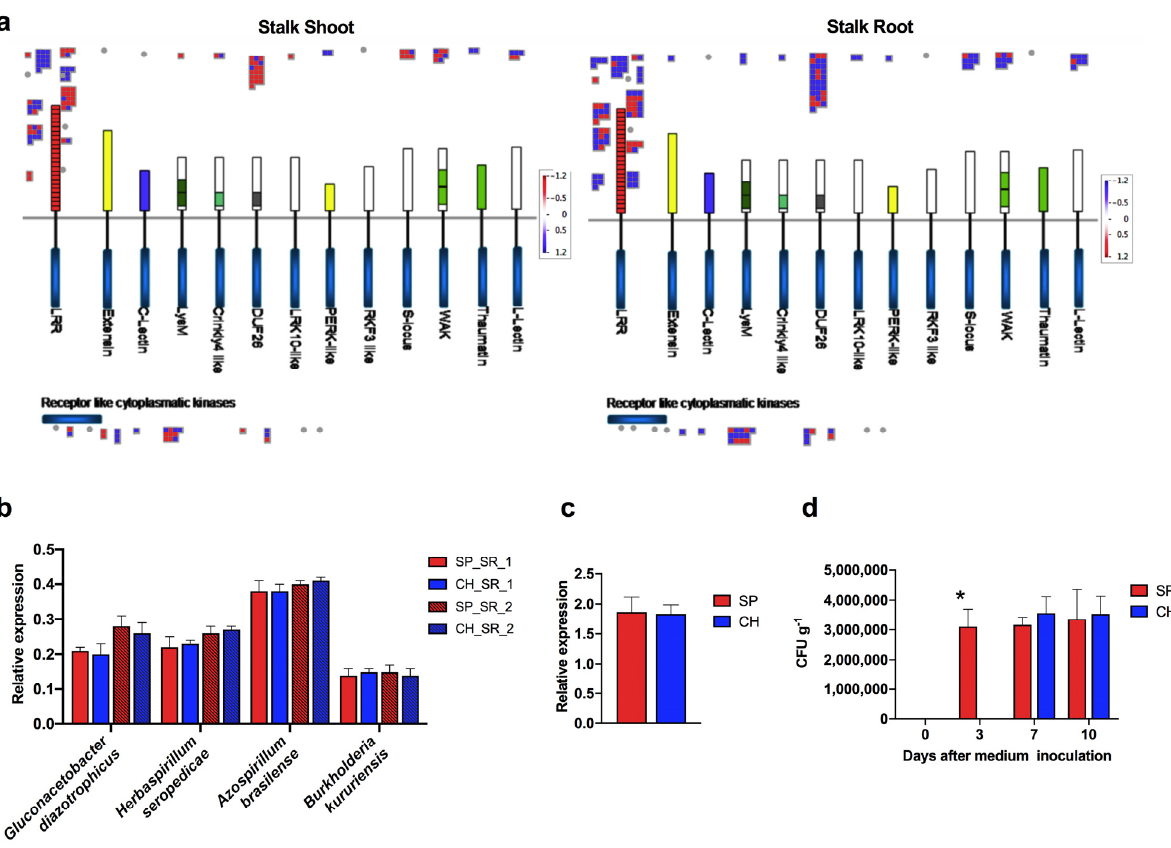
Figure 5. Evaluation of biotic stress response pathways differentially regulated between BNF-contrasting genotypes and bacteria colonization. ( a ) Schematic representation of different plant receptor families, showing the DETs identified in shoot and root tissues of germinated stalks. In red are represented the transcripts that are more expressed in SP and in blue are represented the ones more expressed in CH. ( b ) Relative levels of G. diazotrophicus , H. seropedicae , A. brasilense and B.